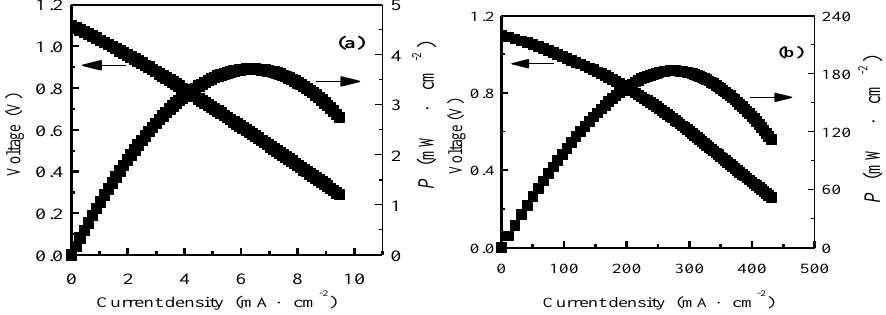
Figure 8. I - V - P curves of the single cell with SrCe 0.9 Sm 0.1 O 3-α (SCS) ( a ) and SrCe 0.9 Sm 0.1 O 3-α -NaCl-KCl (SCS-NK) ( b ) electrolyte at 700 °C.